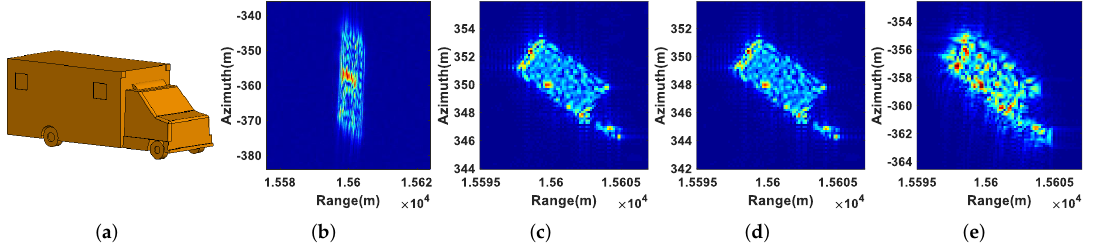
Figure 10. Refocusing results of T6: ( a ) shape of T6; ( b ) Defocusing result; ( c ) refocusing result using the real 2D velocity; ( d ) refocusing result using the estimated 2D velocity; ( e ) refocusing result using the PGA